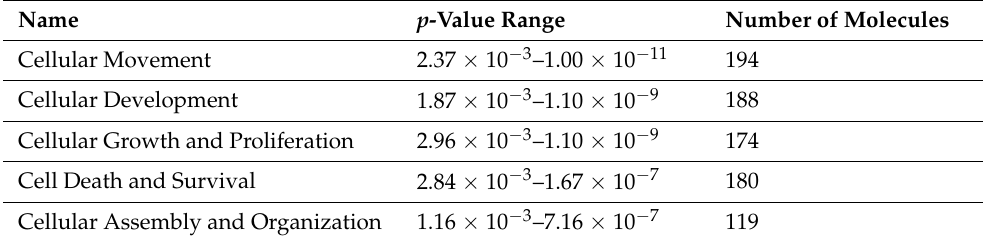
Table 3. Top molecular and cellular functions